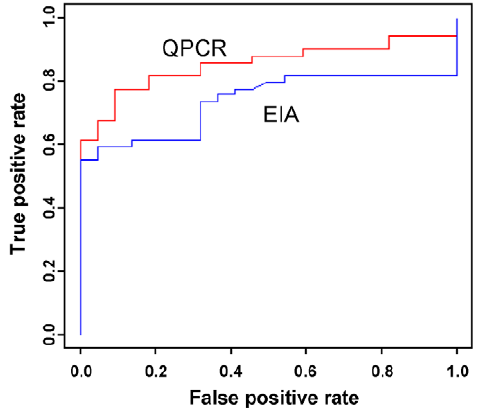
Fig. 3. Comparison of the ROC curves for QPCR and EIA were de- signed on the basis of HER2/28SEC copy number ratios in IHC 3 + positive tumours and healthy